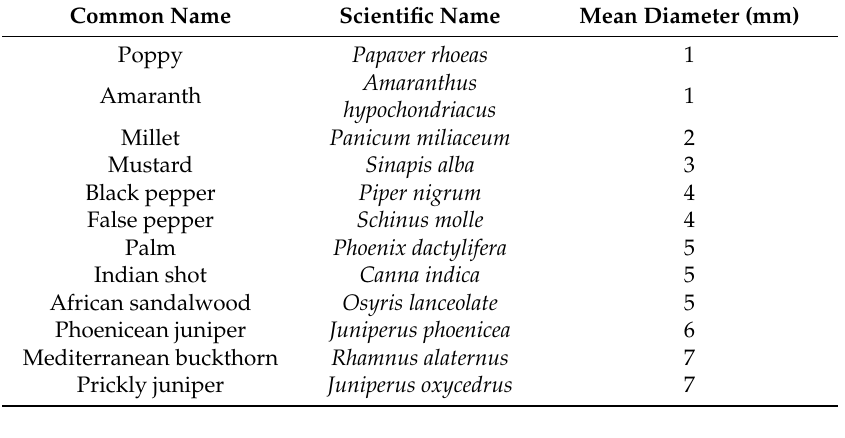
Table 1. Common and scientific names of the selected spherical seeds and their diameters.